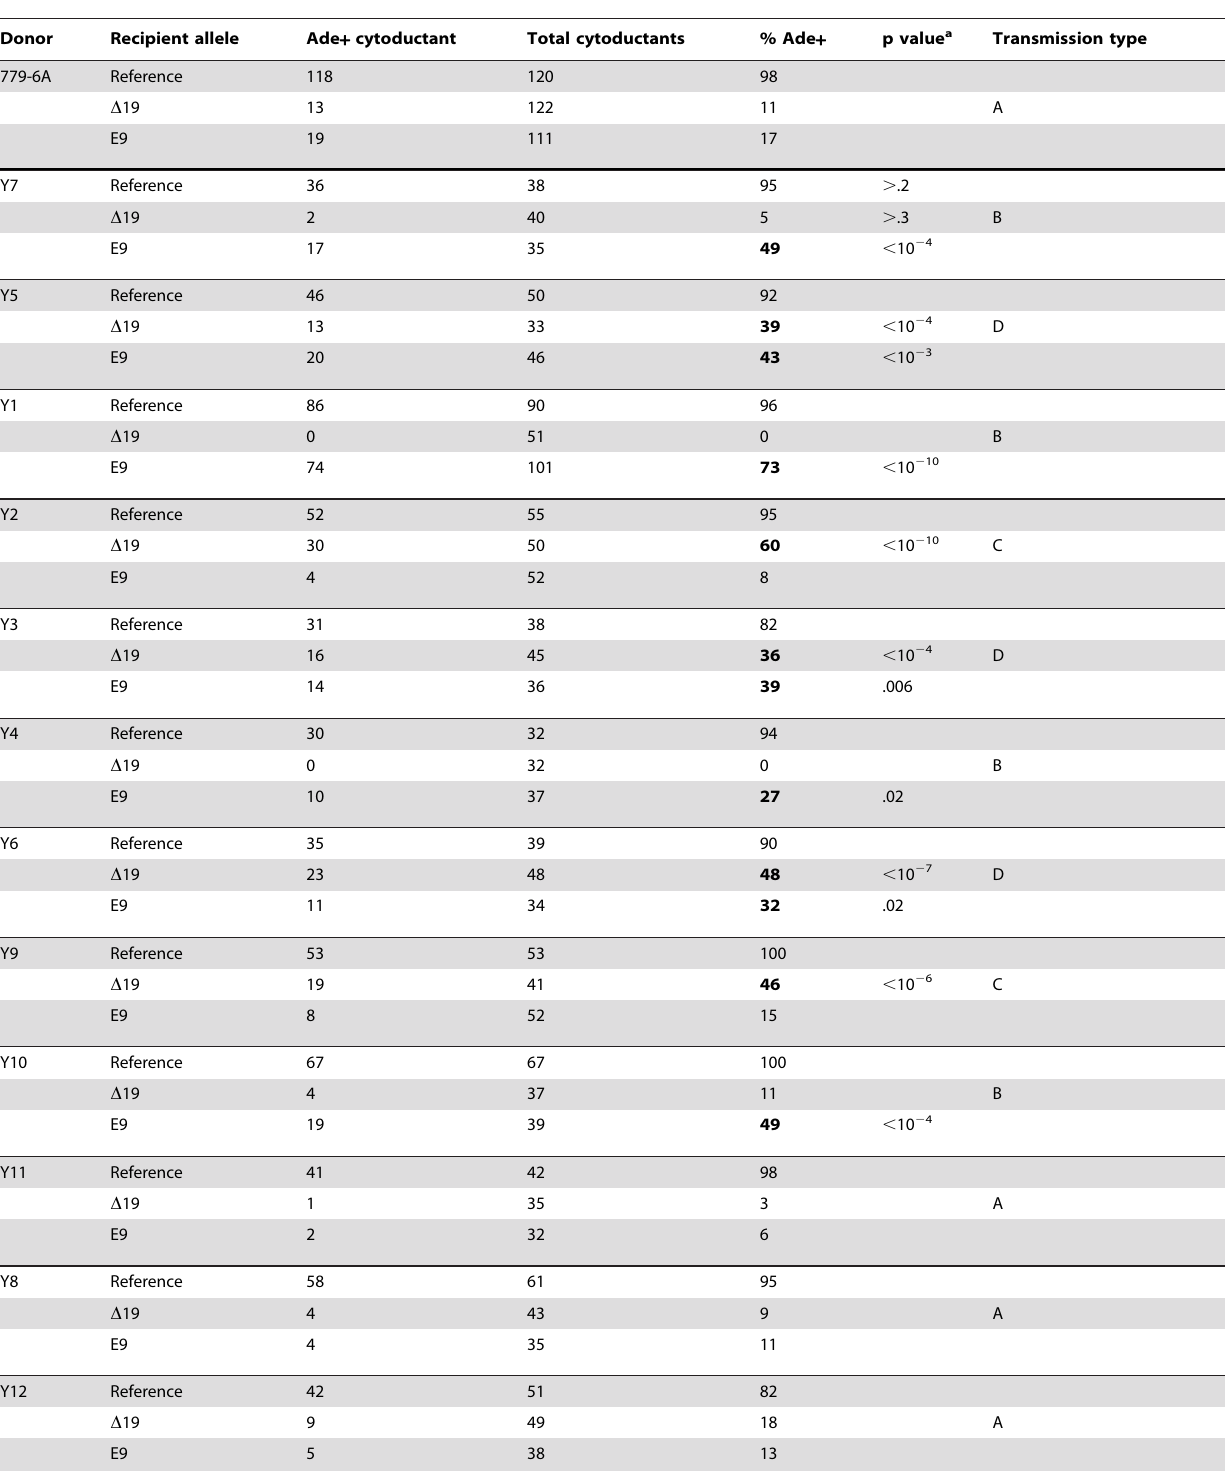
Table 5. Subclones of [ PSI + ref] develop divergent transmission properties without